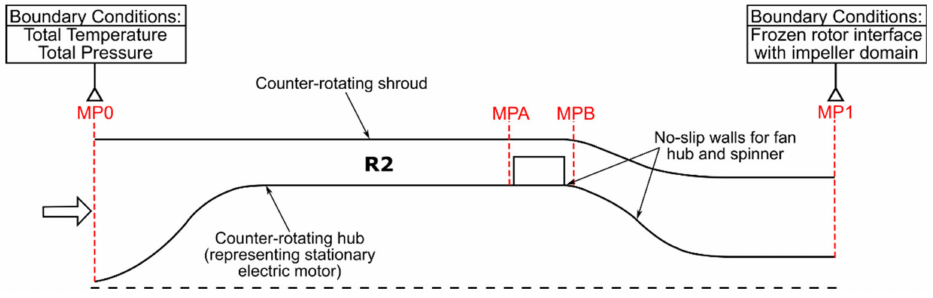
Figure 5. CFD setup for fan domain and measurement plane naming conventions. (Reproduced with permission from Taylor & Francis Group, ©2021 [1]).